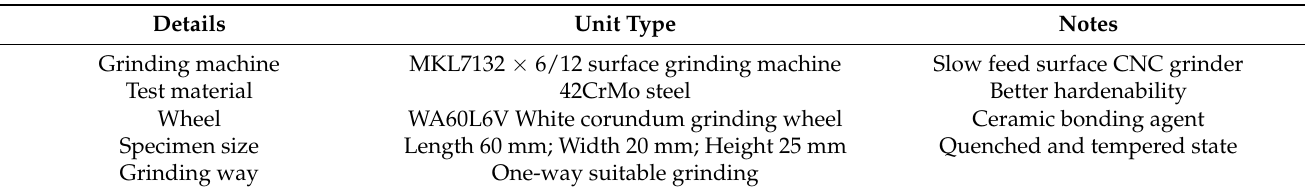
Table 4. Experimental conditions.